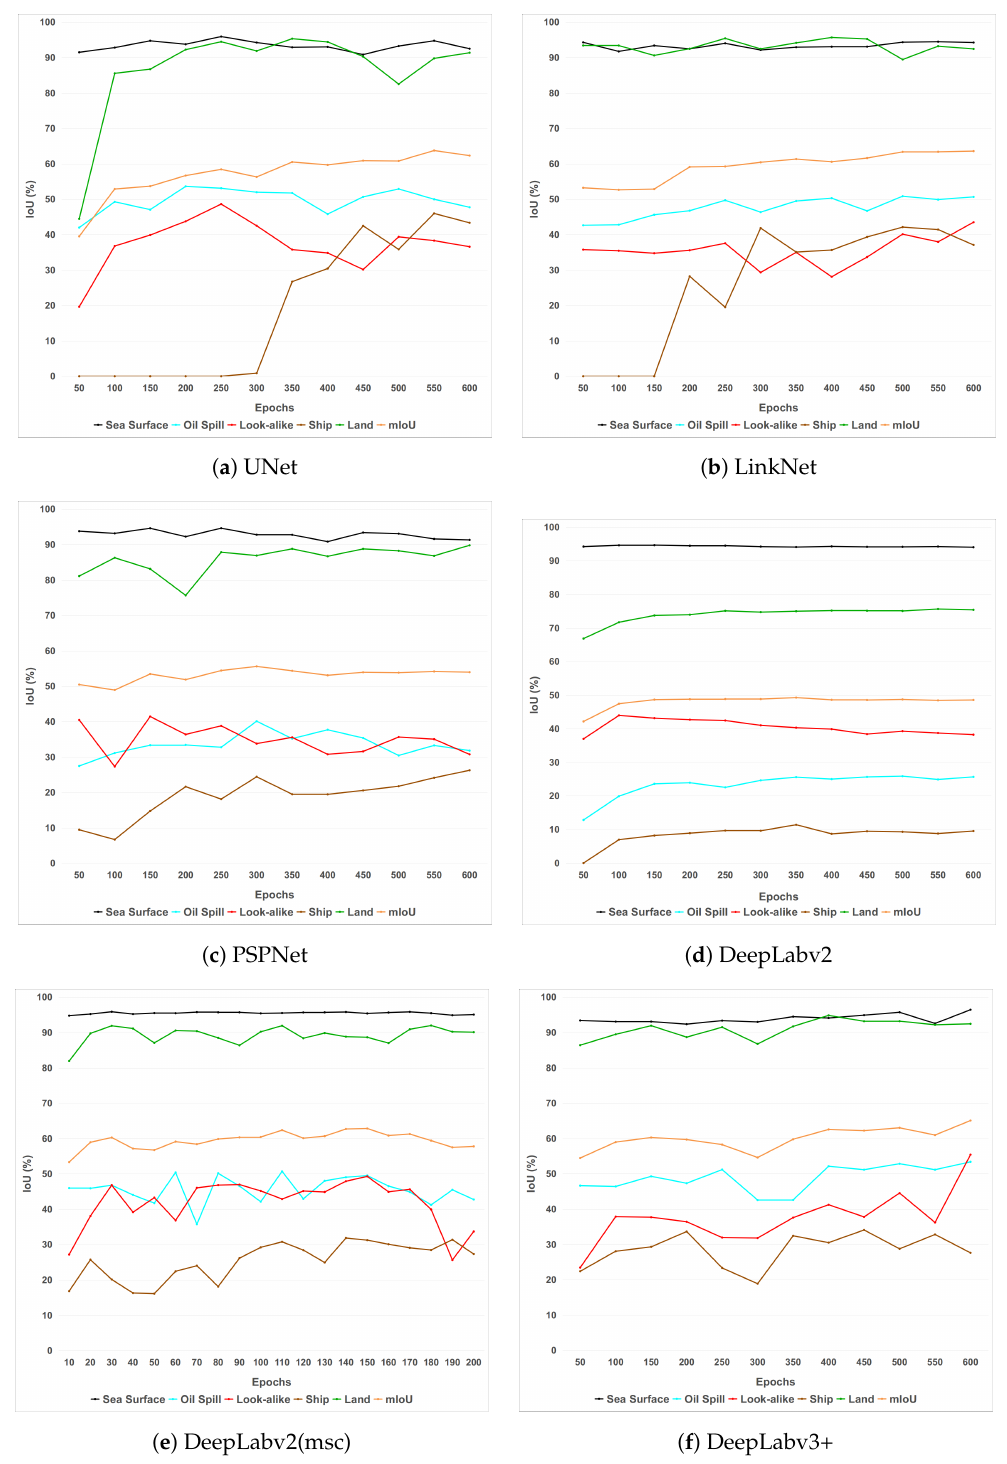
Figure 5. Comparison of different architectures in terms of IoU measured in testing set for each class, over a range of training epochs. Black corresponds to “sea surface”, cyan to “oil spill”, red to “look-alike”, brown to “ships” and green to “land” class, while orange is for the reported